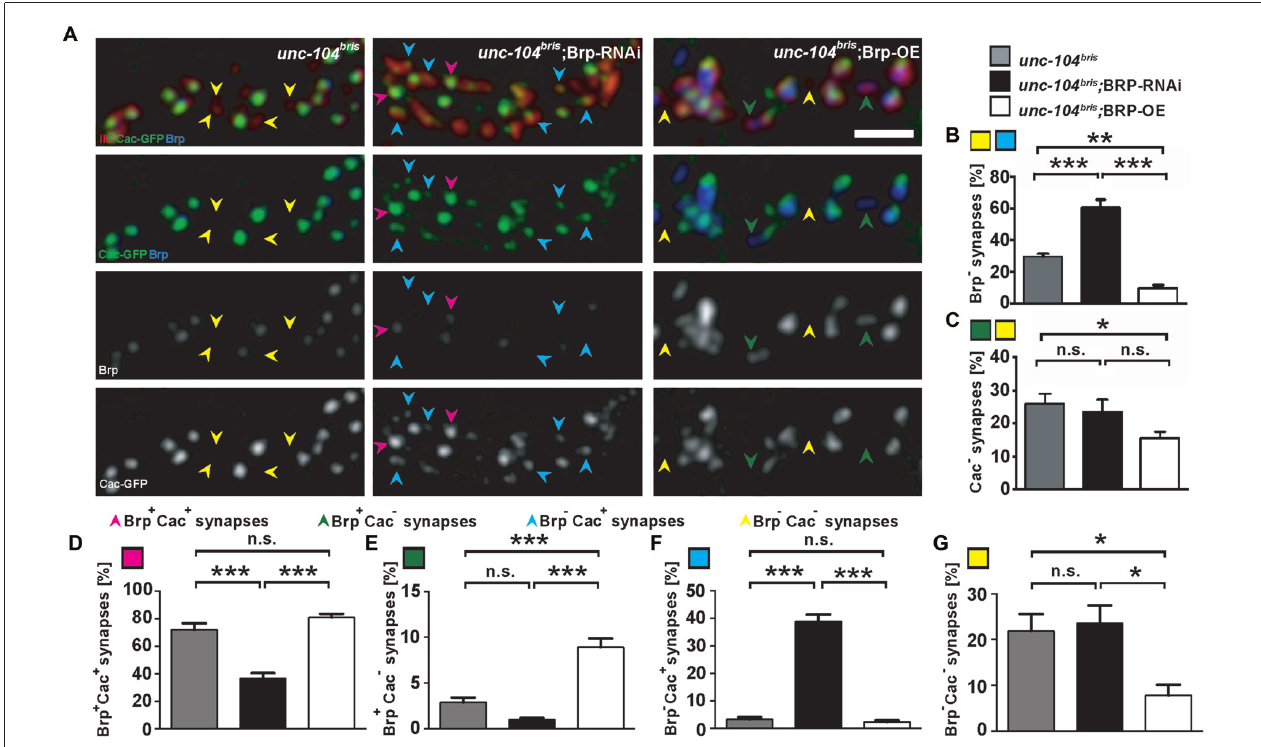
FIGURE 3 | Impact of varying Brp levels on presynaptic Brp and Cac in unc-104 bris background. (A) A stretch of synaptic boutons at the NMJ costained with antibodies against GluRIIC (red, upper panel) and Brp (blue in upper panel, gray in 3rd panel). Cac was visualized by expression of Cac-GFP (green in 2nd panel, gray in lower panel). Mutant unc-104 bris NMJs are characterized by frequent absence of both Brp and Cac-GFP (yellow arrowheads). The frequency of Brp − synapses increases in unc-104 bris ; Brp-RNAi and decreases in unc-104 bris ; Brp-OE NMJs, however, the availability of Cac-GFP does not follow the same trend. (B,C) Quantifications of the percentage of Brp − (B) and Cac − (C) synapses as shown in (A) . (D–G) Quantifications of the percentages of Brp + Cac + (magenta arrowheads in A,D ), Brp + Cac − (green arrowheads in A,E ), Brp − Cac + (blue arrowheads in A,F ) and Brp − Cac − (yellow arrowheads in A,G ) synapses. Genotypes in (A) : unc-104 bris ( elavX-Gal4/+;unc-104 bris /unc-104 d 11024 ;UAS-Cac-GFP/+ ), unc-104 bri ;Brp-RNAi ( elavX-Gal4/+ ; unc-104 bris /unc-104 d 11024 ; UAS-Brp-RNAi/ UAS-Cac-GFP ), unc-104 bri ;Brp-OE ( elavX-Gal4/+ ; unc-104 bris /unc-104 d 11024 ; UAS-Brp/UAS-Cac-GFP ). Experiments were performed at 29 ◦ C. Scale bar: 2 µ m. Statistical test: one-way ANOVA followed by Tukey’s Multiple Comparison Test. ∗ p < 0.05; ∗∗ p < 0.01; ∗∗∗ p < 0.001; n.s. p > 0.05. Error bars represent